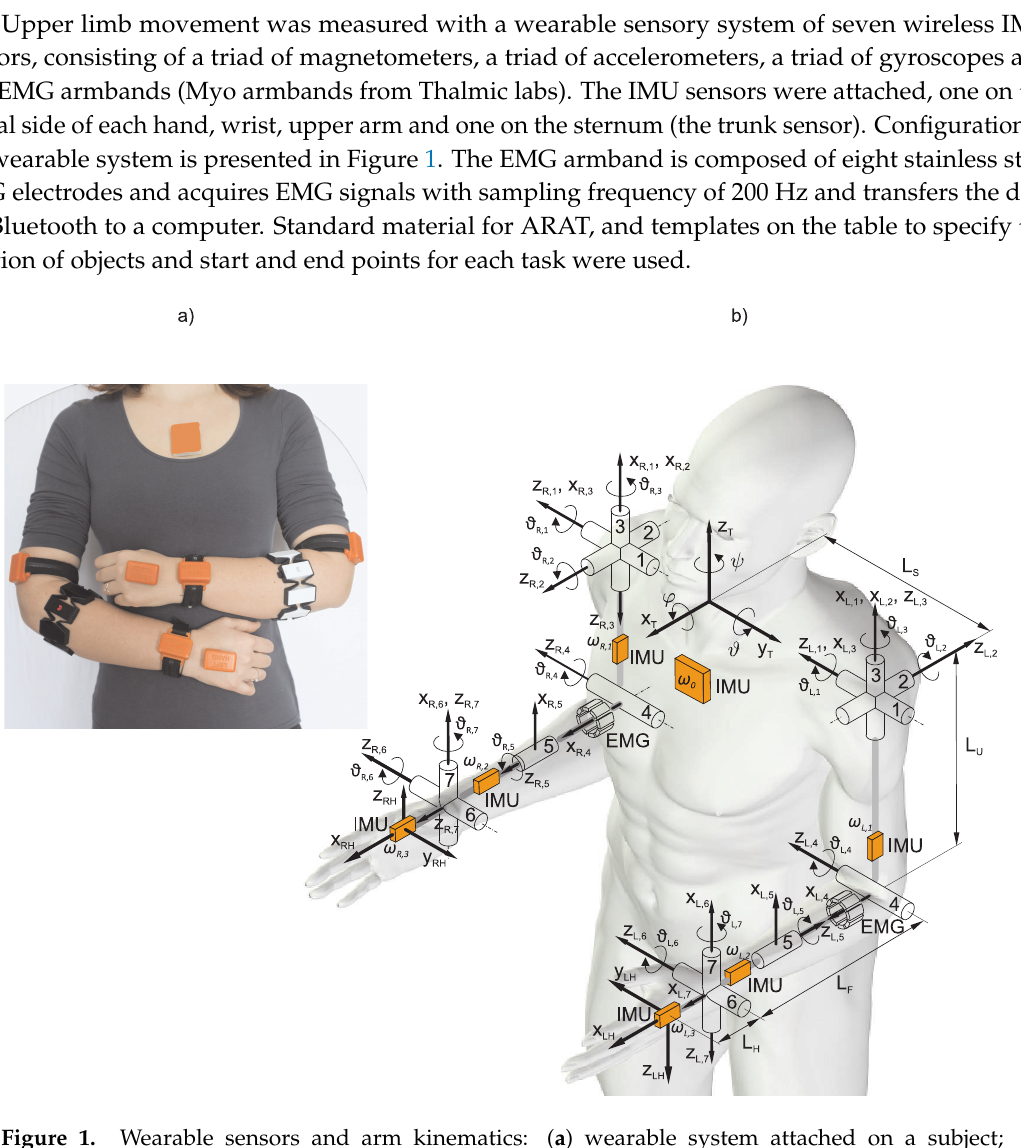
Figure 1. Wearable sensors and arm kinematics: ( a ) wearable system attached on a subject; and ( b ) kinematic model of the trunk and arms with joints (cylinders), segments and coordinate systems. Orange boxes represent IMU sensors, and the two segmented cylinders represent armband EMG